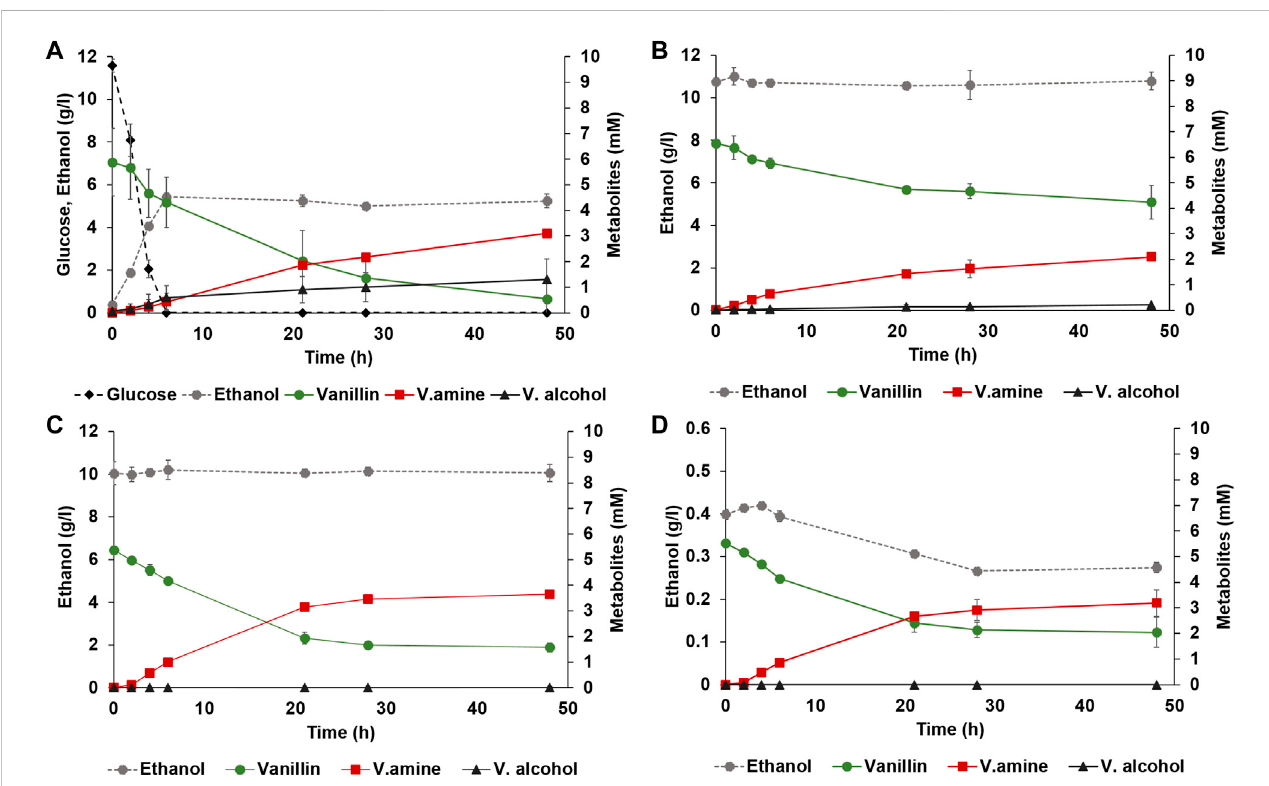
FIGURE 2 Anaerobicwhole-cellbioconversionsofvanillintovanillylaminewithyeaststrainTMBNM033,co-expressingCvTAandBsAlaDH,andwithdeletedADH6. Reactionsweremadeinserumvialsspargedwithnitrogenusingde fi nedmineralmediumsupplementedwith (A) glucoseandalanine; (B) 10 gL − 1 ethanoland alanine, (C) 10 g L − 1 ethanol, and without alanine, or (D) 0.5 g L − 1 ethanol and without alanine. Co-substrates glucose (black diamond) or ethanol (dotted line with grey circle) are shown on the left axis, and the metabolites vanillin (green circle), vanillylamine (red square) and vanillic alcohol (black triangle) are shown on the right